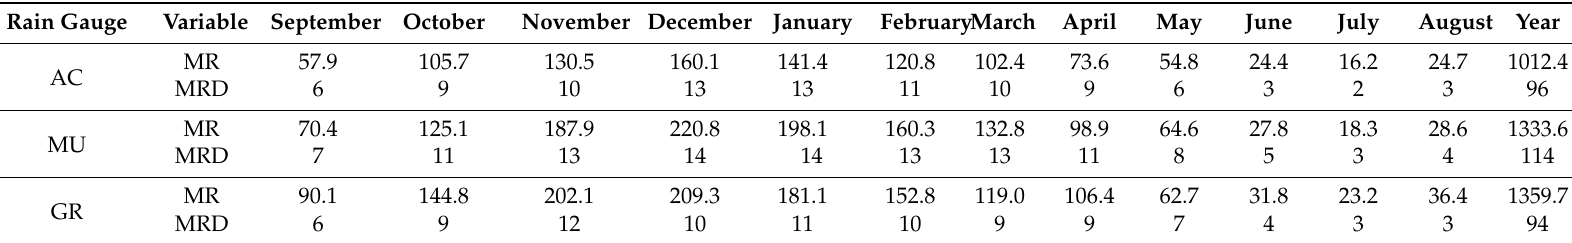
Table 1. Average monthly and annual rainfall (MR, in mm) and number of rainy days (MRD) at rain gauges near the considered case studies. Key: (AC) Acri rain